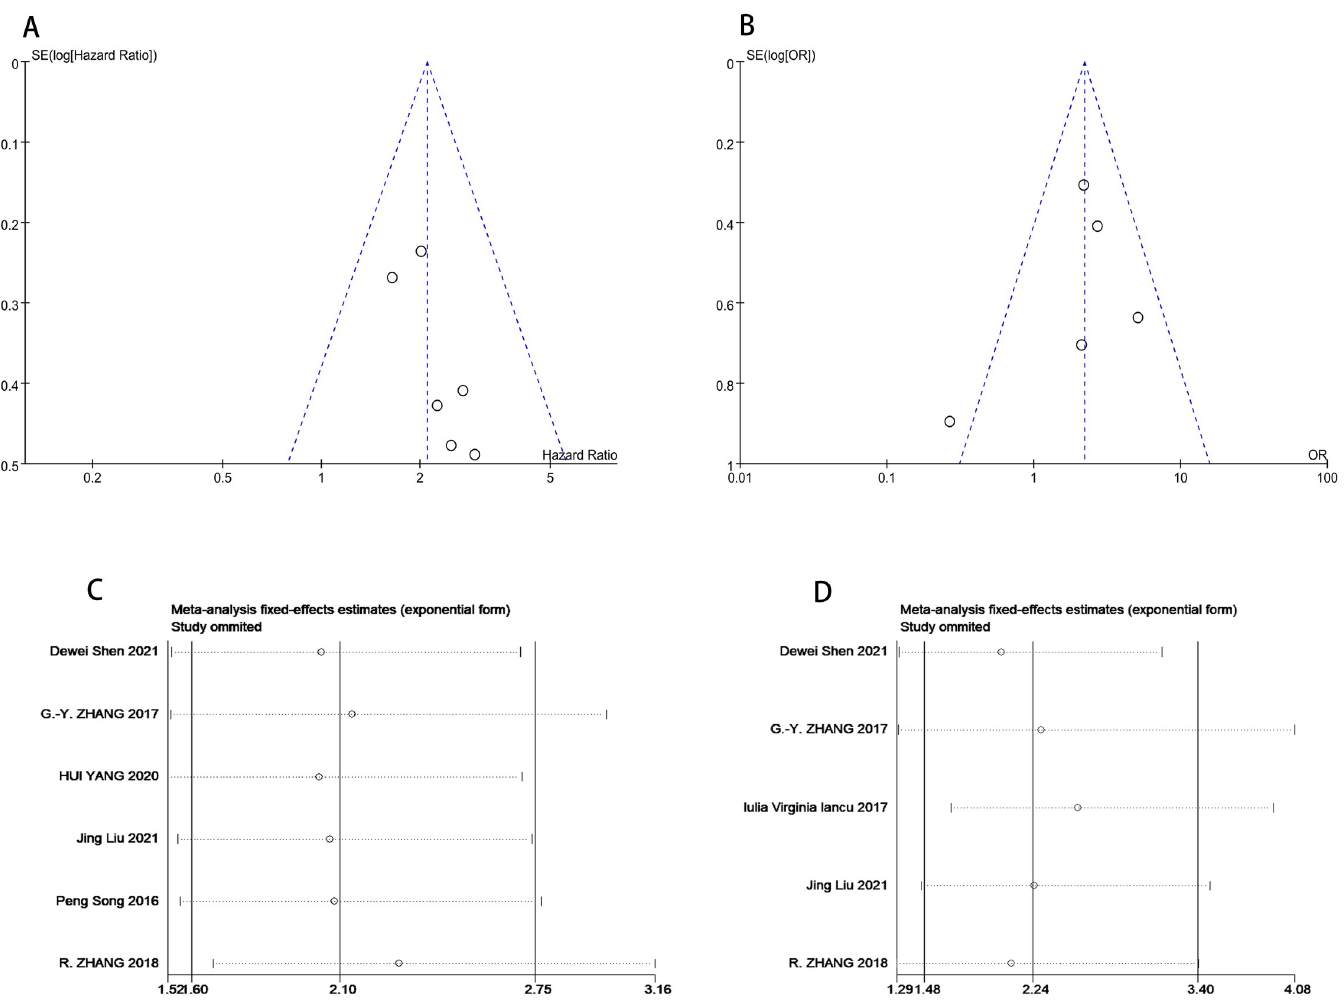
Fig 4. Funnel plots and sensitivity analyses. (A) Funnel plots for studies involved in analysis of HR and OS, (B) OR and metastasis;(C) Sensitivity analysis for studies involved in analysis of HR and OS, (D) OR and metastasis.